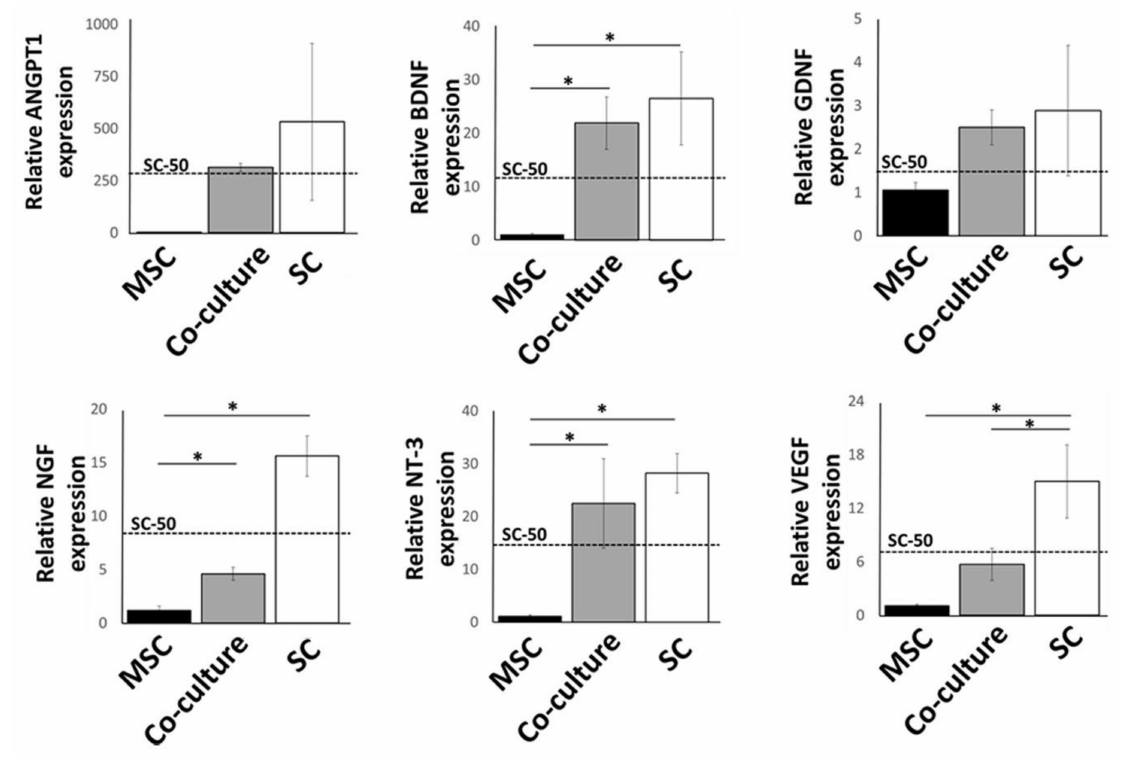
Figure 2. qRT-PCR analysis of neurotrophic and growth factor expression in MSCs, Schwann cells (SC), and co-cultured cells (1:1). Relative expression levels are given with respect to the MSCs samples with expression value set nominally at 1. Dashed line shows SC-50; the expected value at 50% Schwann cell population. Error bars are standard errors from the mean; * indicates a significant difference between groups as determined by one-way ANOVA followed by Tukey’s post hoc test where p < 0.05; n =